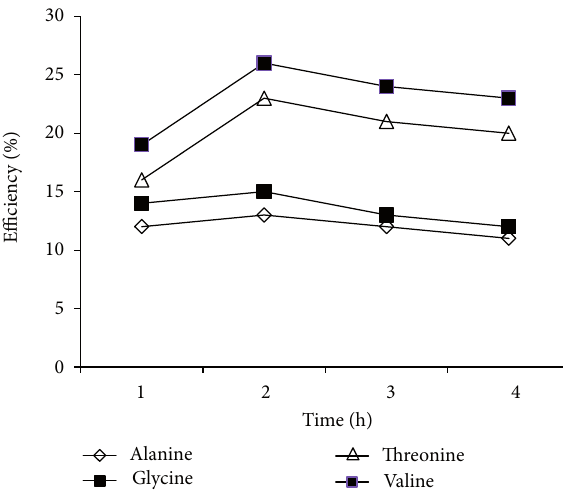
F 4: Efficiency of amino acids extracted without stirring.